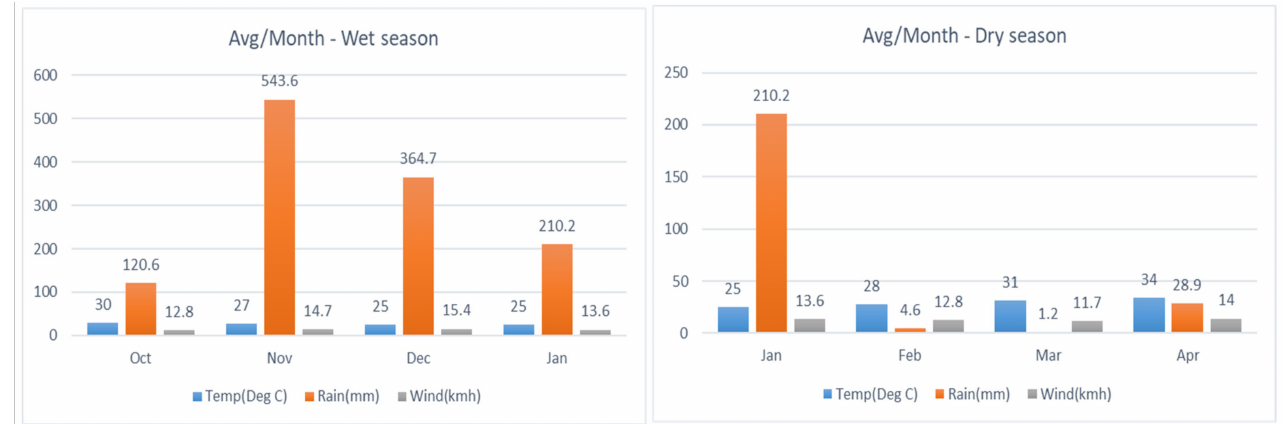
Figure 7. Average monthly temperature, rainfall and wind speed of the experimental site in both wet and dry